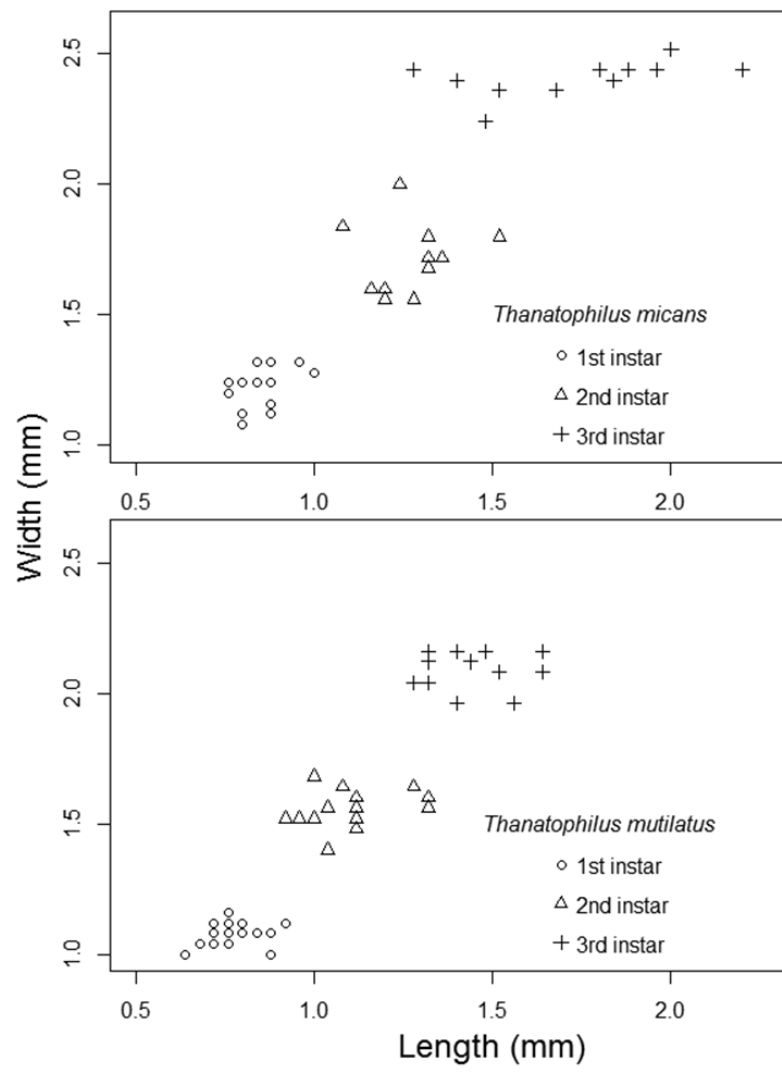
Figure 3. Scatter plot of head width against head length of larvae of T. micans and T. mutilatus . Each in- star has a characteristic head width that allows individuals to be assigned unambiguously to a growth stage Epipharynx bilobed anteriorly, with margin denticulate, without curved lateral setae. Postmentum large, with five pairs of